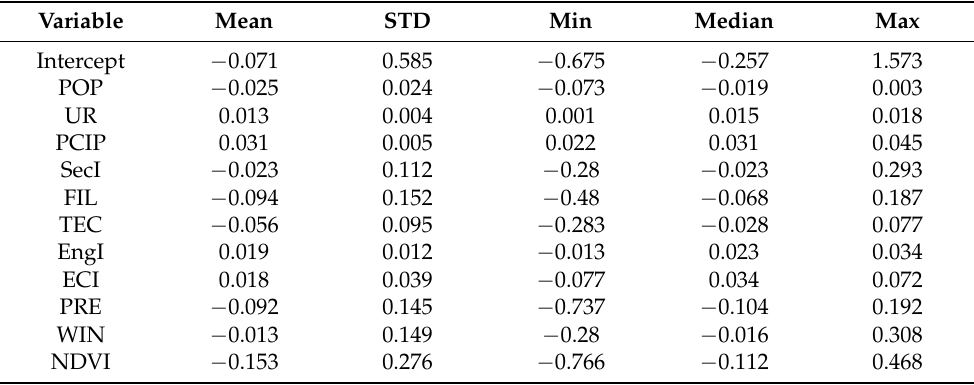
Table 2. Summary statistics for MGWR parameter